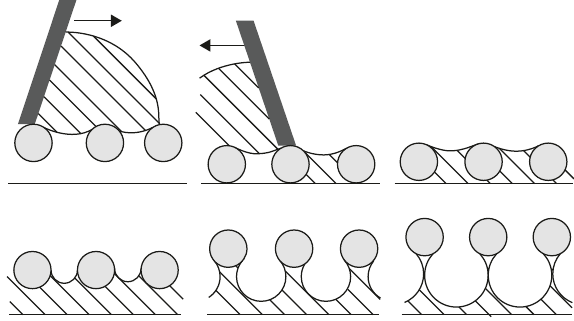
Figure 1: Schematic diagram of ink transfer.